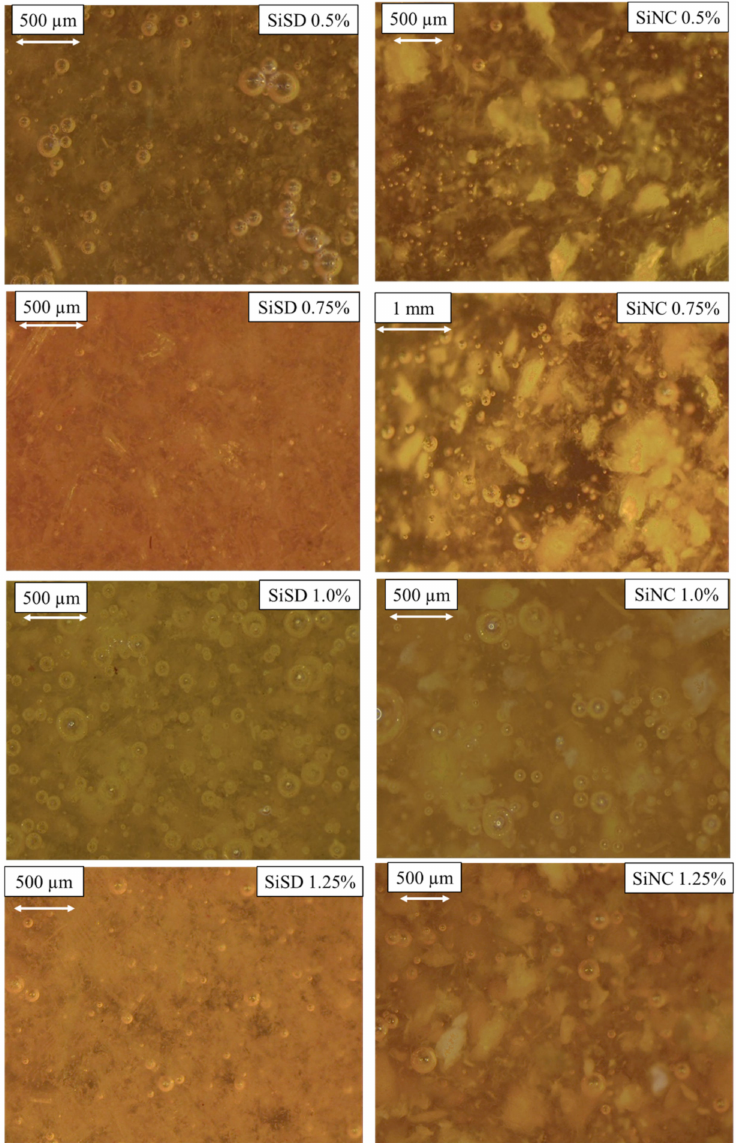
Figure 10. Dispersions of fillers in polyol mixture for 0.5%, 0.75%, 1.0%, and 1.25% PP40 composites. As depicted in Figure 10, SiSD and SiNC dispersions in polyol mixture did not make either agglomerates stratified, and particle arrangement was rather even. Possible compactions may be decreased by optimizing the dispersion